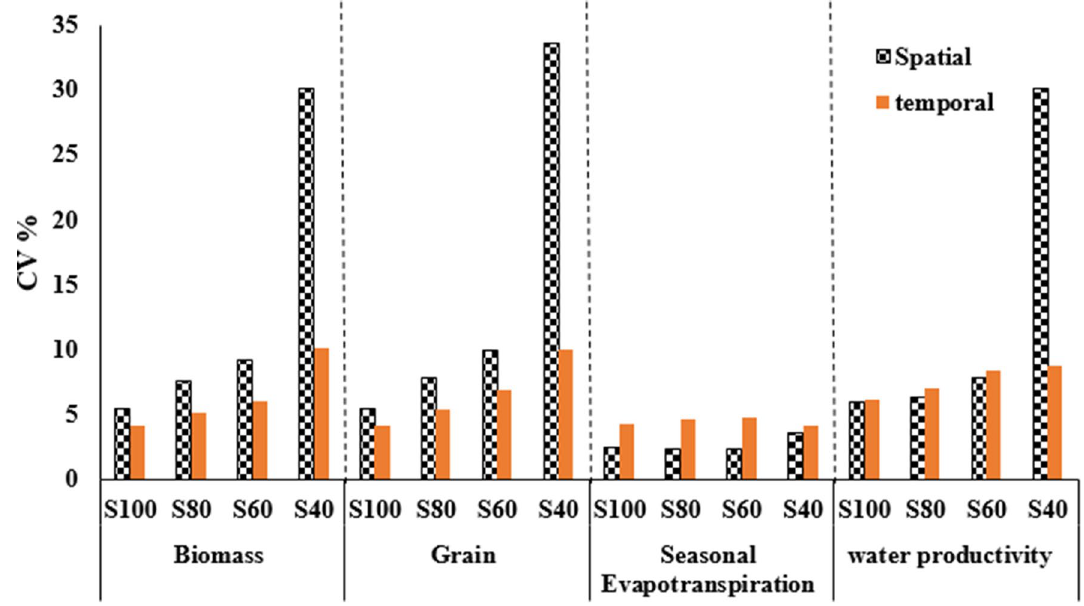
Fig. 9 Comparison of spatial and temporal CVs of studied parameters under irrigation